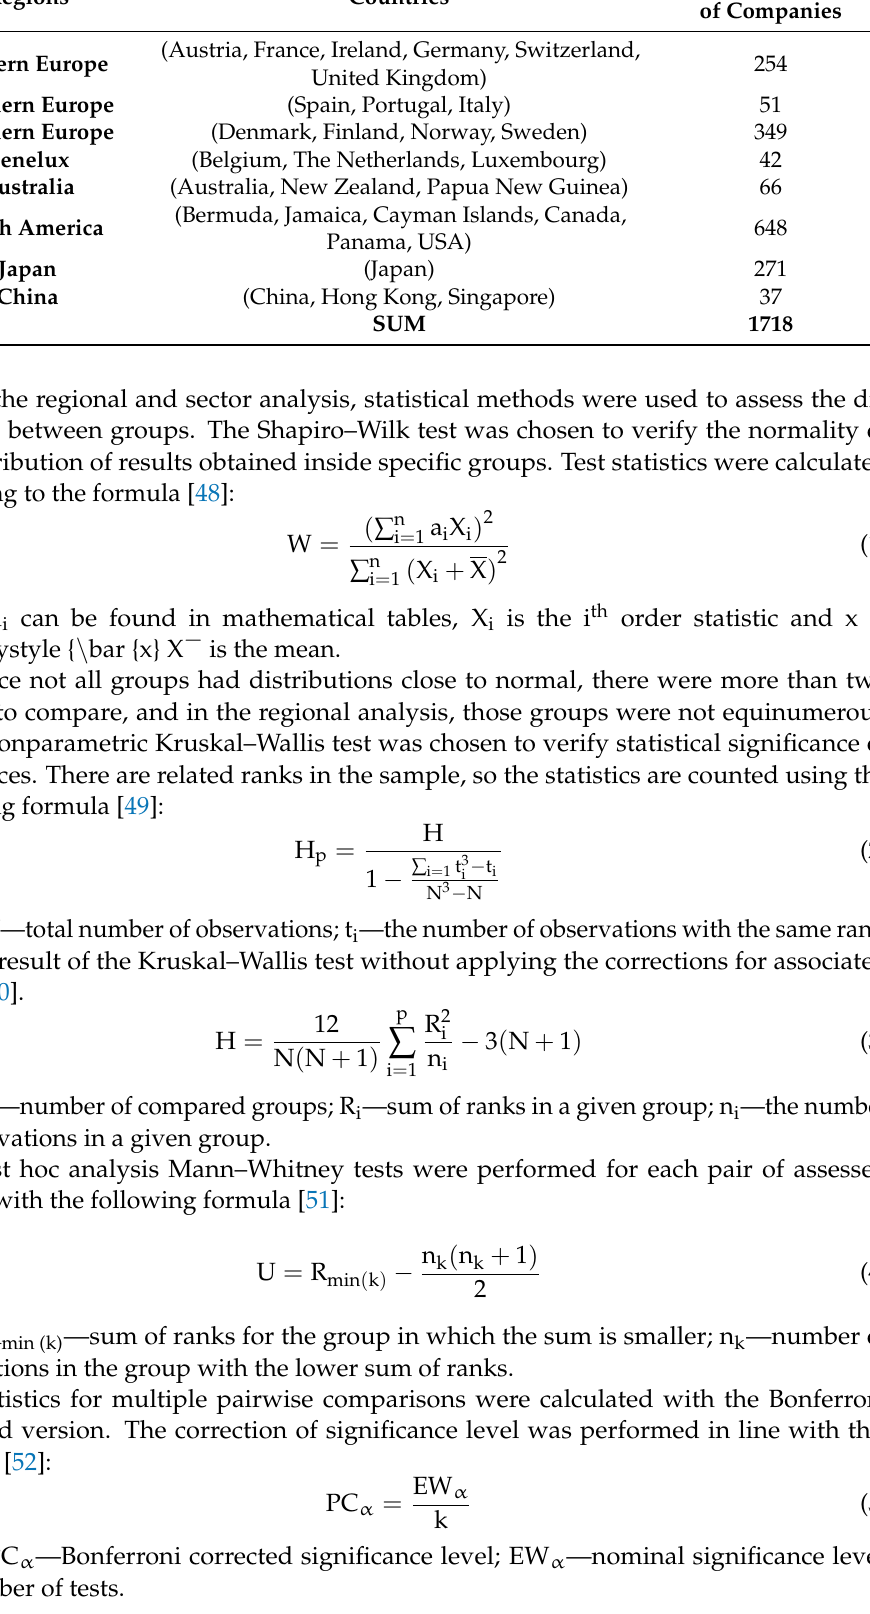
Table 3. Number of companies in the study according to regions.